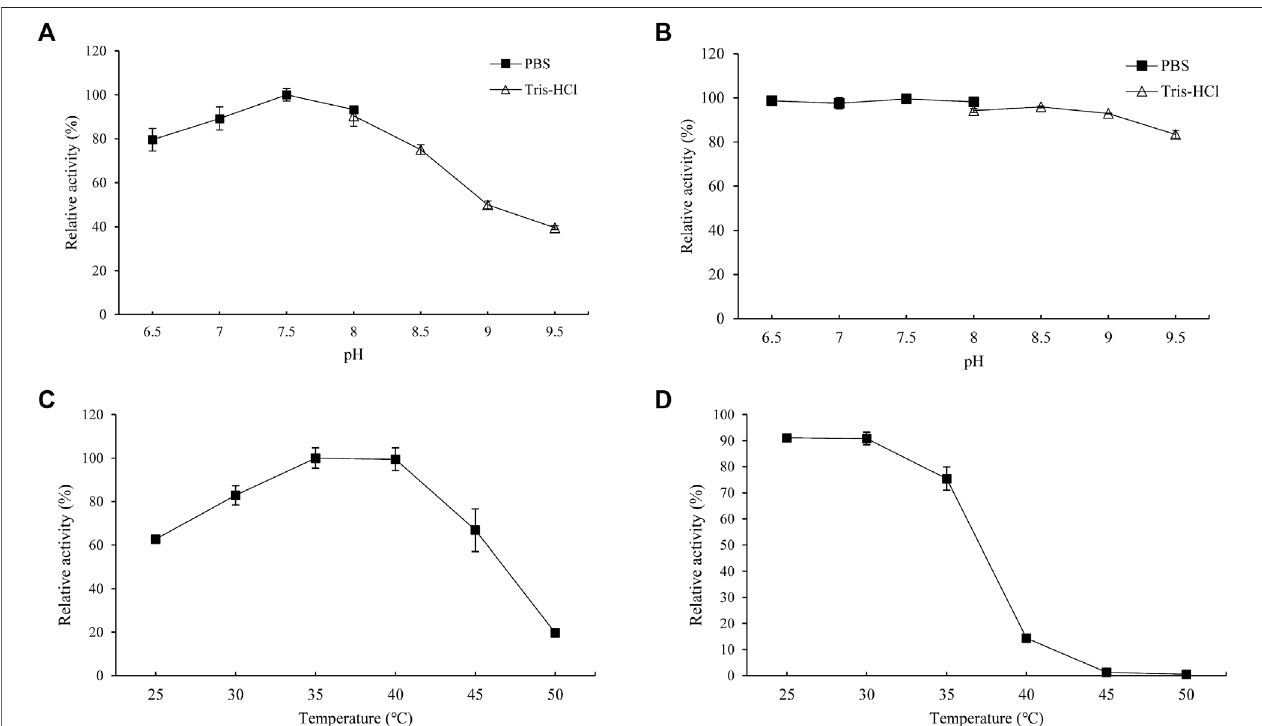
FIGURE 3 | Optimal pH (A) , pH stability (B) , optimal temperature (C) , and thermal stability (D) of PgUGT. Error bars represent standard deviations, and three replicates were